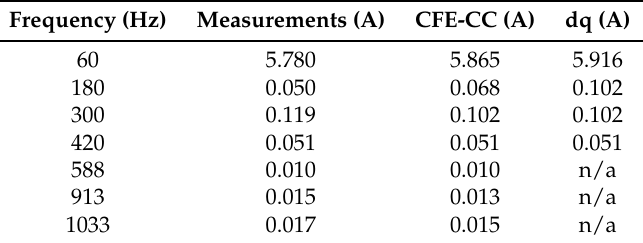
Table 4. Main frequency components in stator current.